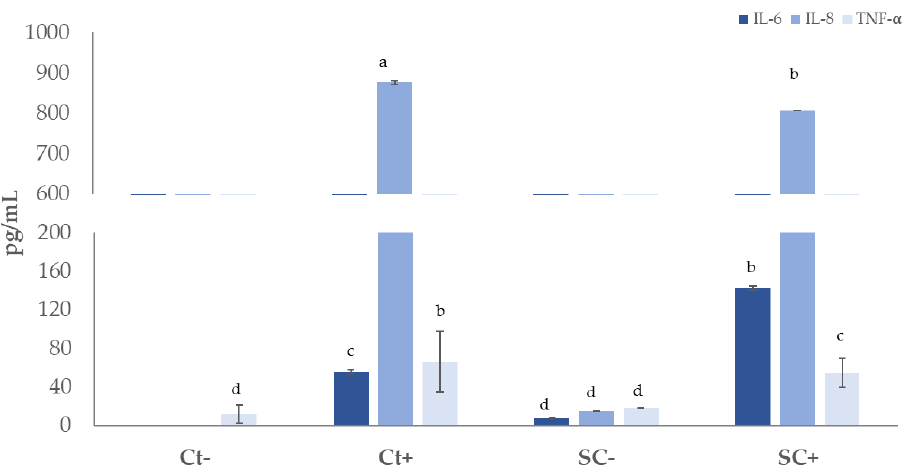
Figure 7. Immunomodulatory effect on Caco-2 cell line after exposition to fermented sugarcane straw extract (0.625 mg/mL) with (SC+) and without S. cerevisiae (SC − ), using IL-1 β as a pro-inflammatory stimulus. The concentration of interleukin-8 (IL-8), interleukin-6 (IL-6), and tumor necrosis factor (TNF-) (mean ± SD) were measured. a,b,c,d Different letters indicate significant differences ( p < 0.05).